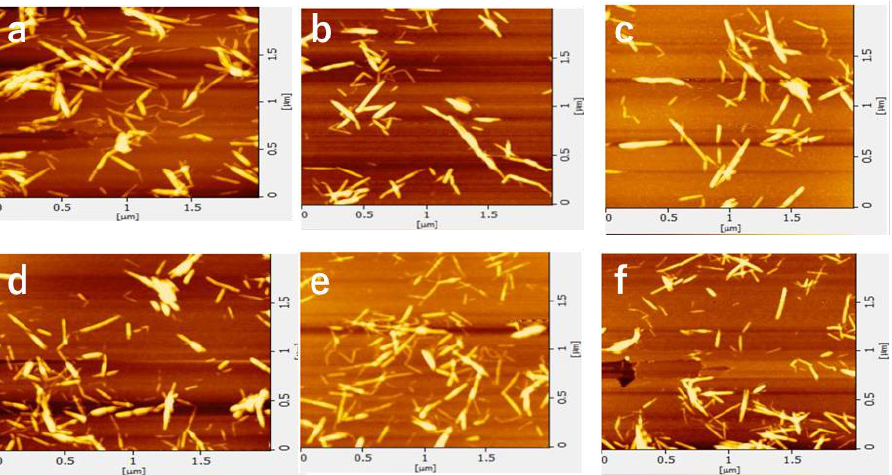
Figure 3. AFM images of partially deacetylated chitin nanofibers with ultrasonication time of ( a ) 5, ( b ) 10, ( c ) 15, ( d ) 20, ( e ) 25, and ( f ) 30 min.